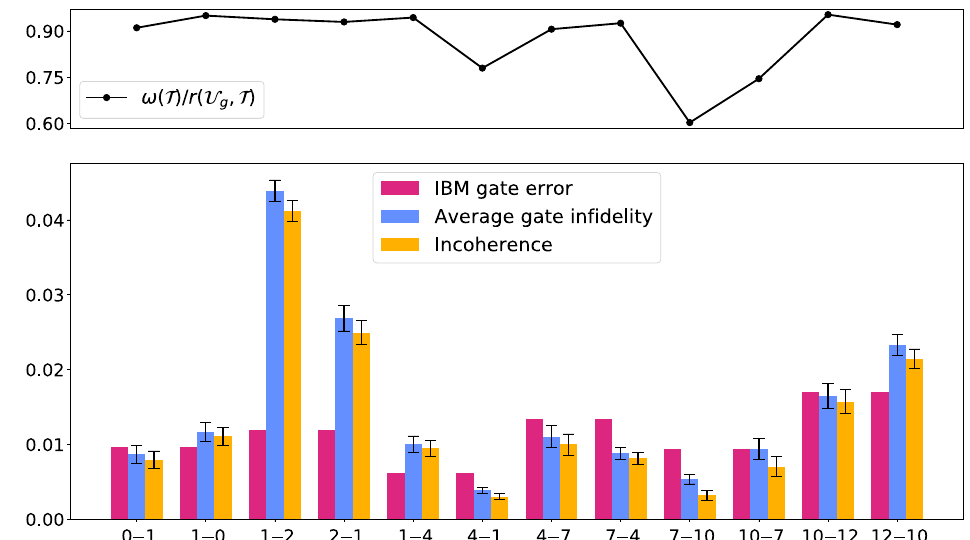
FIG. 9. The error analysis of the set of CNOT gates in IBMQ_GUADALUPE employed for the simulation of the second set of results in Fig. 8. The tick 0–1 on the x axis corresponds to the CNOT gate, where “qubit 0” in IBMQ_GUADALUPE is the control qubit and “qubit 1” is the target. The lower plot shows the gate error provided by IBM (magenta), the experimental average gate infidelity r ( U g , T ) via full process tomography (light blue), and the incoherence ω( T ) (yellow), as defined in Eq. (9). The error bars on the values of r ( U g , T ) and ω( T ) are the standard deviations of 100 realizations of a random sample of the experimental data via bootstrapping. The upper plot shows the ratio between the incoherence and the experimental average gate infidelity of each CNOT gate. model introduced in Sec. V D. This is done in Fig. 10.